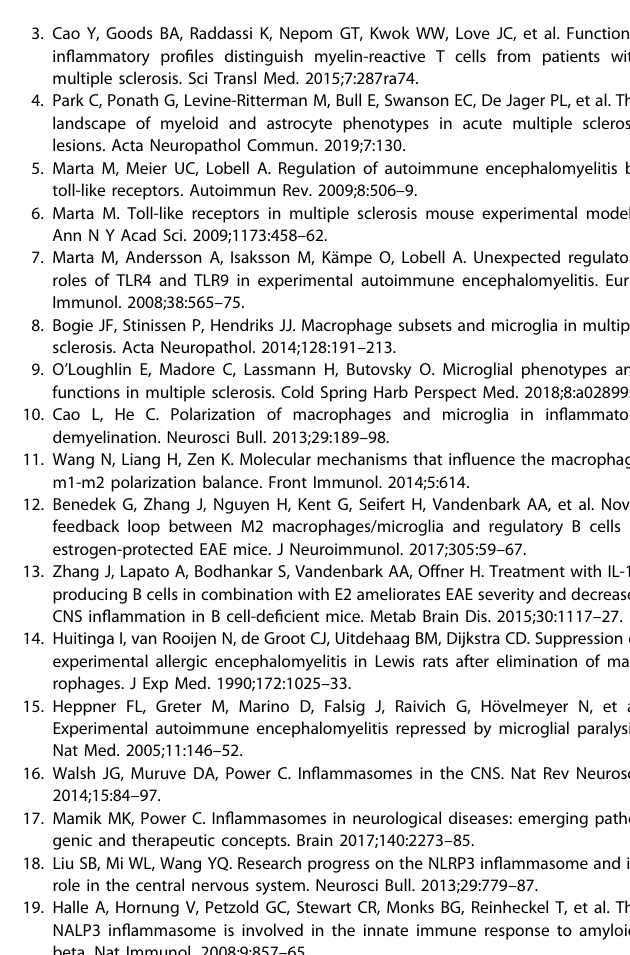
Fig. 8 Schematic and fl ow diagrams illustrate the inhibited function of IRAK-M on activation of NLRP3 in fl ammasomes and GSDMD- mediated pyroptosis via blocking IRAK1/TRAF6 formation. TLR4 signaling is activated post EAE induction, followed by the formation of the MyD88/IRAK4/IRAK1 complex. Immediately after phosphorylation of IRAK1, IRAK1 leaves the complex and associates with TRAF6, which ultimately activates the NF- κ B signaling pathway. The stimulus from TLR4 signaling rapidly promotes NLRP3, ASC, and pro-caspase-1 accumulation to form a cytosolic oligomer, which allows the self-cleavage of pro-caspase-1. Cleaved caspase-1 together with caspase 4/5/11 cleave gasdermin D (GSDMD) to generate the N-terminal domain of GSDMD, which acts as a pyroptosis executor and facilitates the release the proin fl ammatory cytokines IL-1 β and IL-18. In fl ammation and pyroptosis cause injury to microglia in the CNS of EAE. IRAK-M works as a negative regulator of the TLR4-NLRP3 in fl ammation pathway via inhibition of IRAK1 phosphorylation and the subsequent combination of